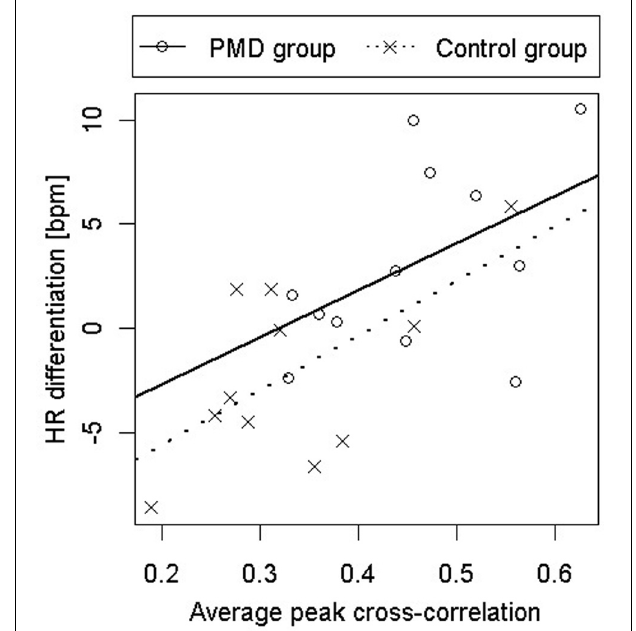
FIGURE 4 | Heart rate acceleration on the deep side of the visual cliff minus heart rate acceleration on the shallow side as a function of responsiveness to peripheral optic flow in infants who received powered-mobility-device (PMD) training and those who did